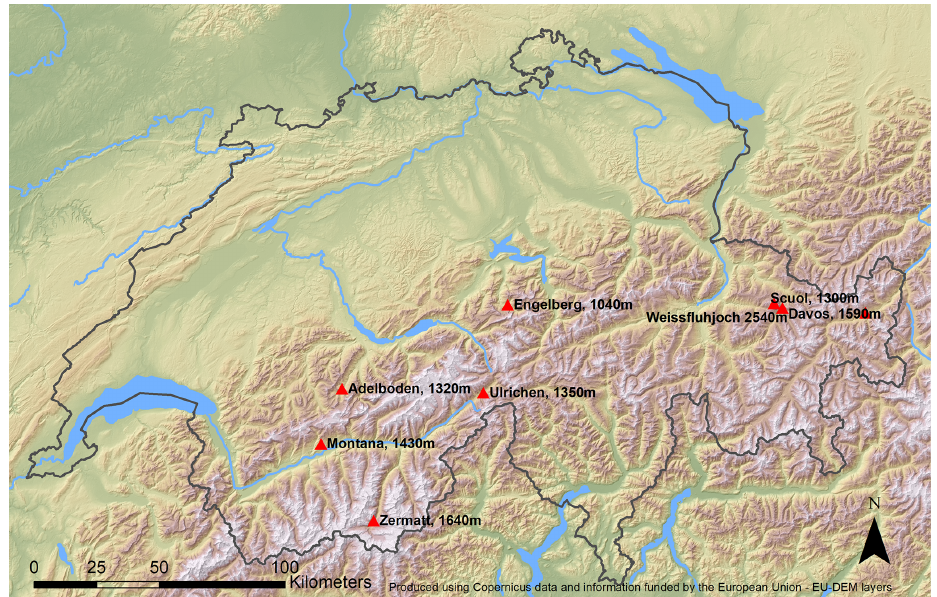
Figure 1. Overview map of case studies used for this study (produced using Copernicus data and information funded by the European Union EU-DEM